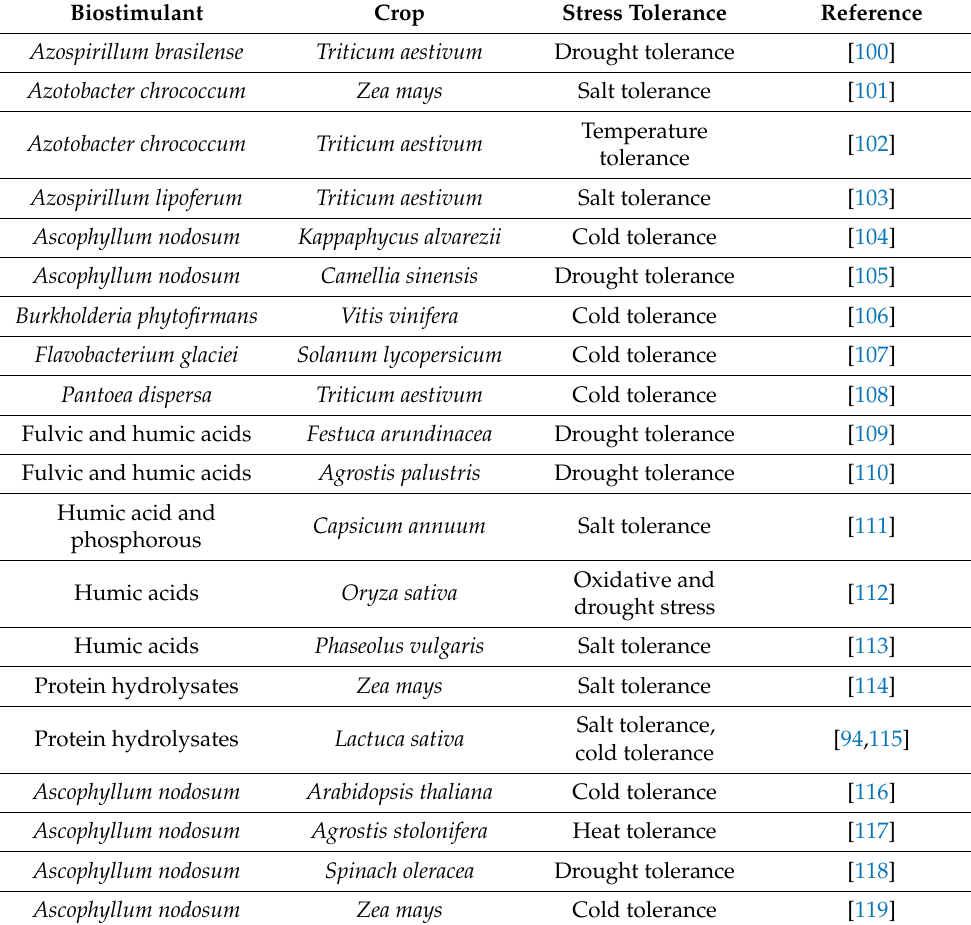
Table 1. Summary of different biostimulants and their abiotic stress-alleviating effect in plants. Biostimulant Crop Stress Tolerance